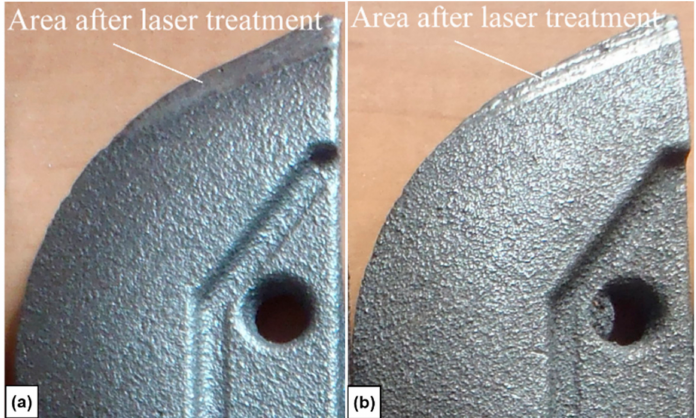
Figure 5. The cultivator coulter after laser implementation of nickel ( a ) and a combination of nickel and chromium ( b